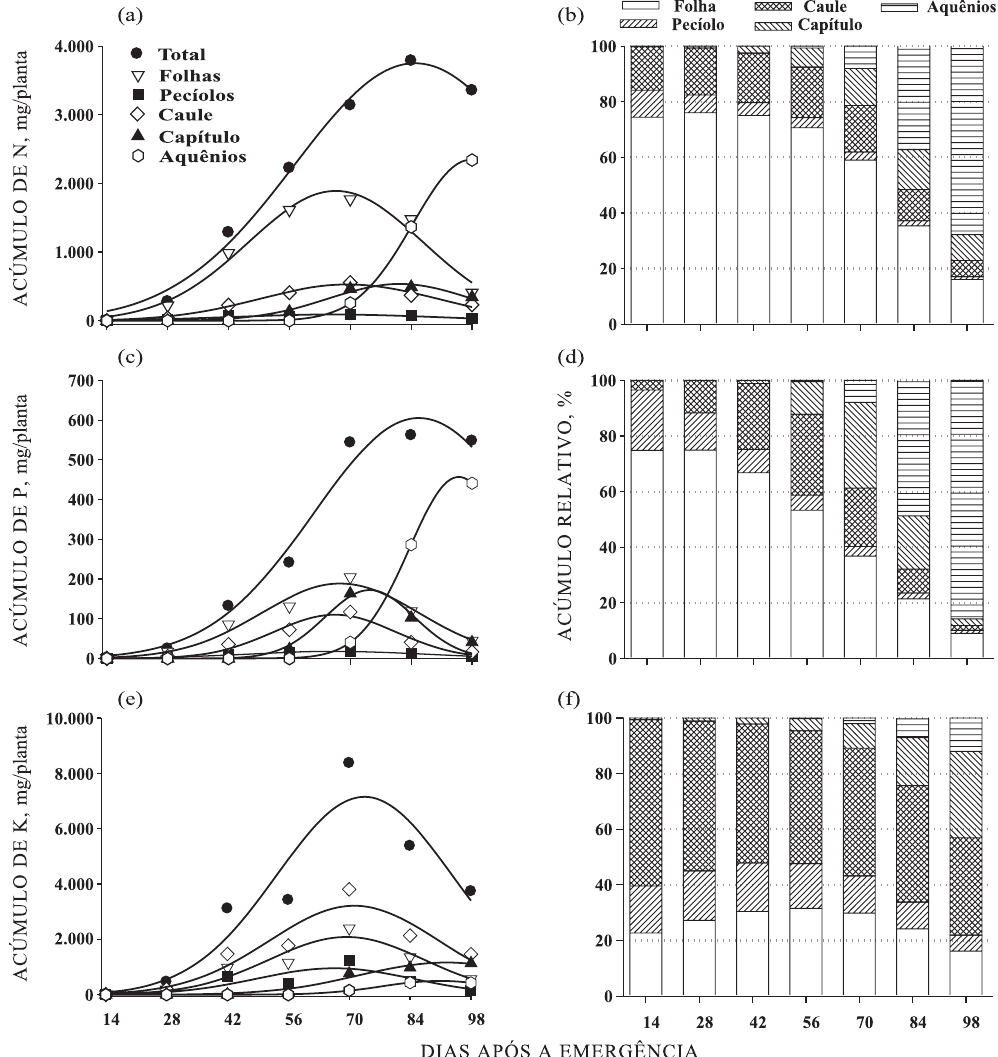
Figura 2. Marcha de absorção dos macronutrientes primários e respectivo acúmulo relativo nas partes das plantas. (a) e (b): nitrogênio; (c) e (d): fósforo; (e) e (f):